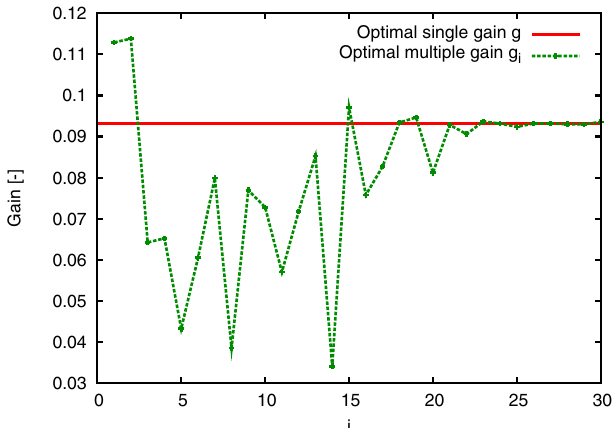
FIG. 17. (Color) Optimal values of a single gain parameter and of multiple gain parameters (for each BPM pattern i ). The optimal single gain g (cid:6) 0 : 093 was used as a starting point for during the gradient search. Since the multiple gain parameters g i the last few BPM patterns correspond to small emittance changes, the corresponding gain parameters were hardly changed by the optimization procedure. Their precise values are of very little importance.